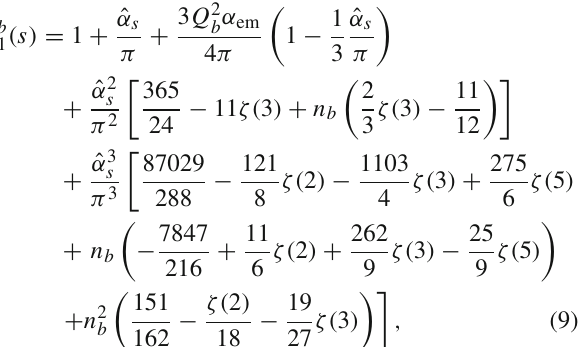
√ √ s ) , α em = α em ( s ) , and n b = 5 is the total where ˆ α s = ˆ α s ( number of active flavors. Using the results of Refs. [27,28], the sum rule for M 0 defined in Eq. (3) reads explicitly,